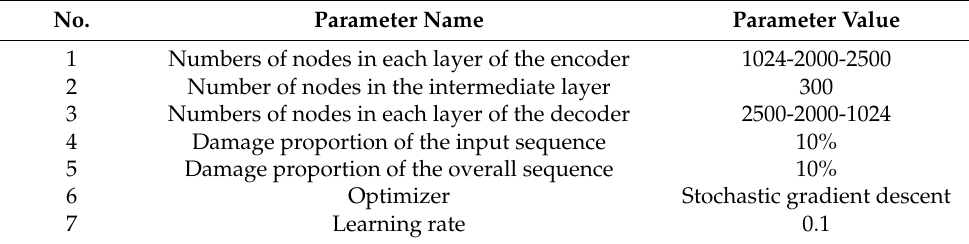
Table 1. Structural parameters of the VSDAE for the time-domain dataset.